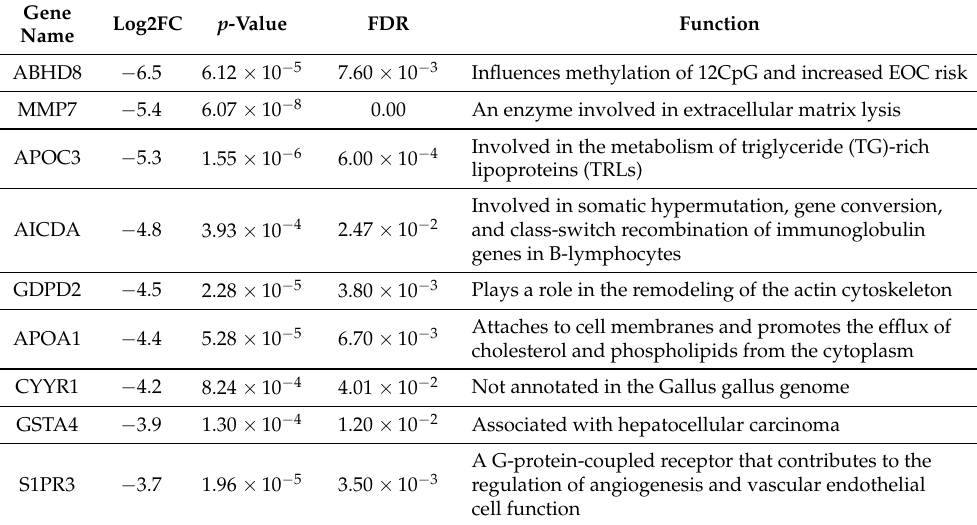
Table 1. Top 10 mRNAs that are downregulated in COVCAR cells in response to 2 mM metformin treatment compared to control as detected by RNA-seq analysis. Functions listed below are that of the protein encoded by the respective gene. FDR-False discovery Rate.